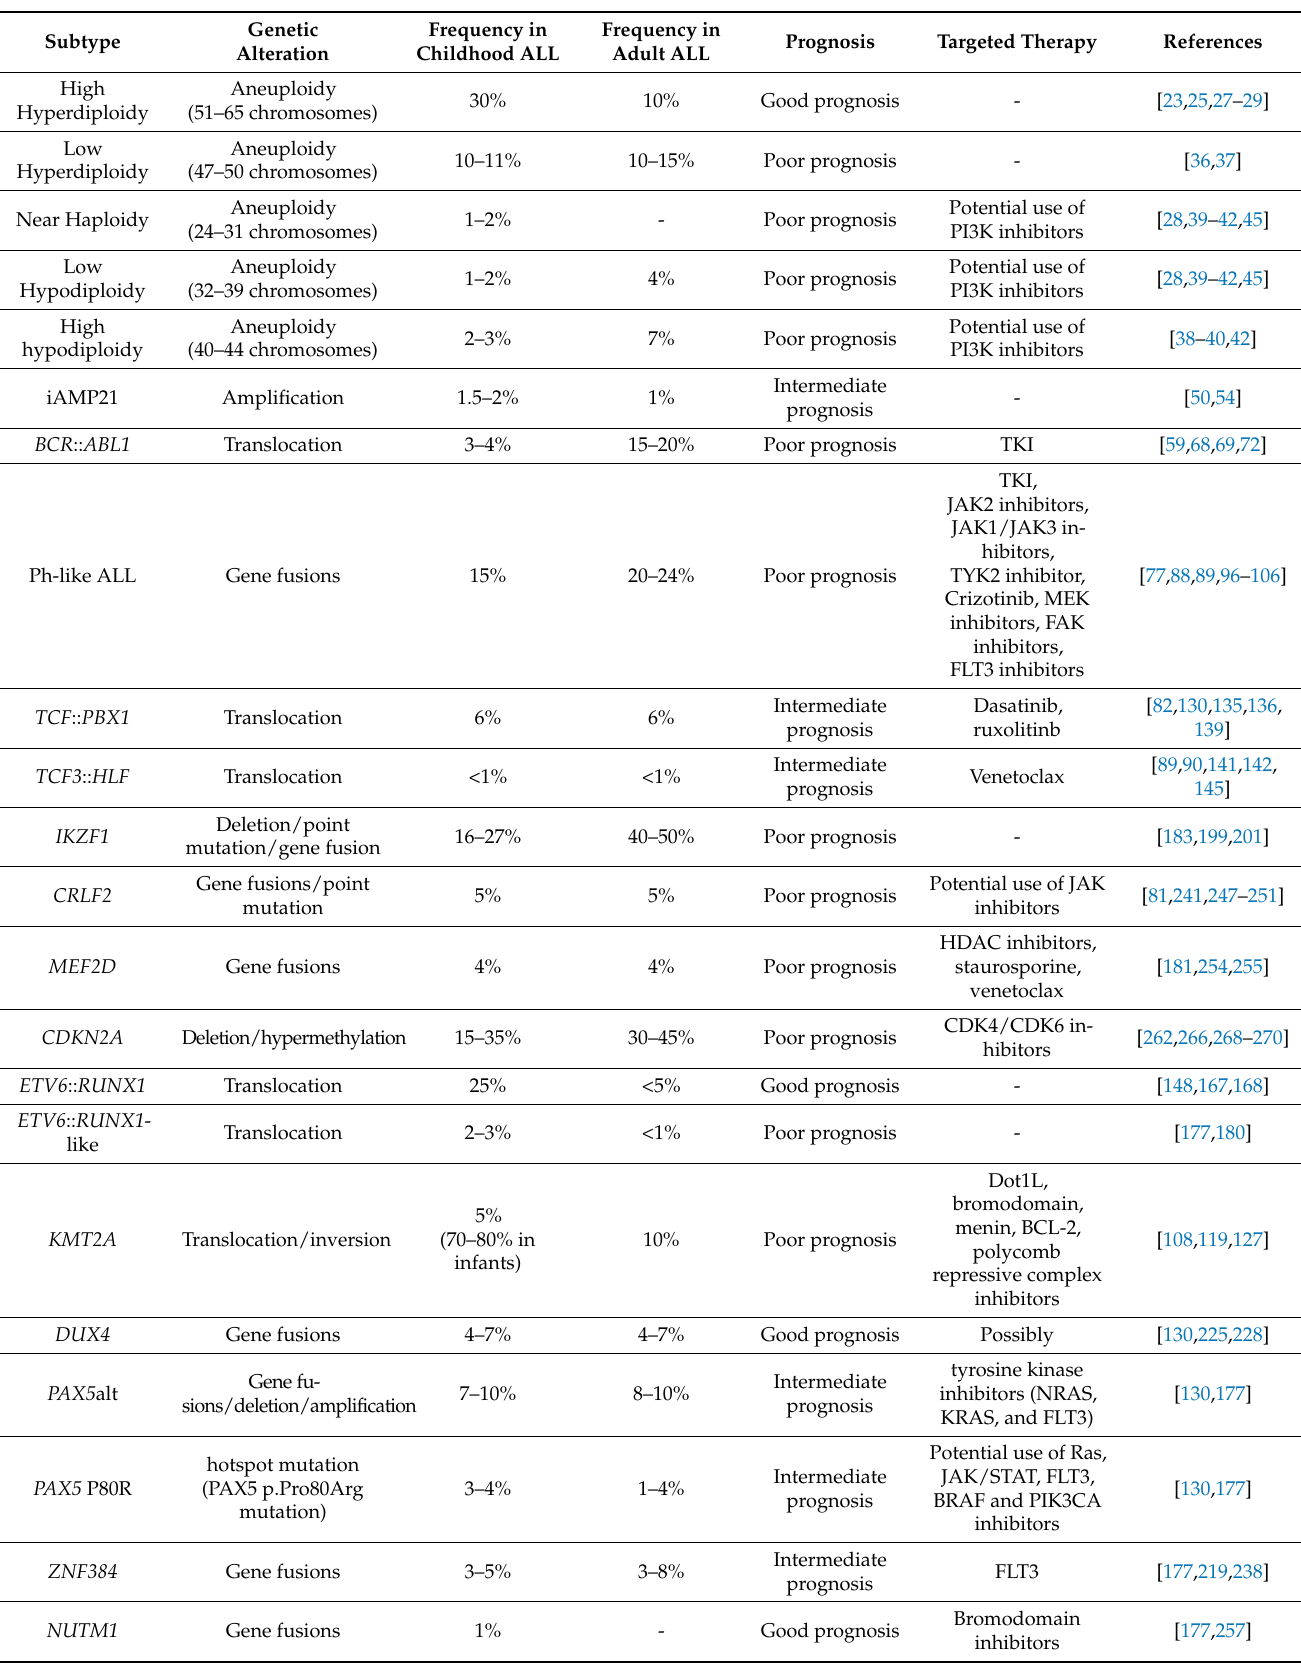
Table 2. Characteristics of B-ALL